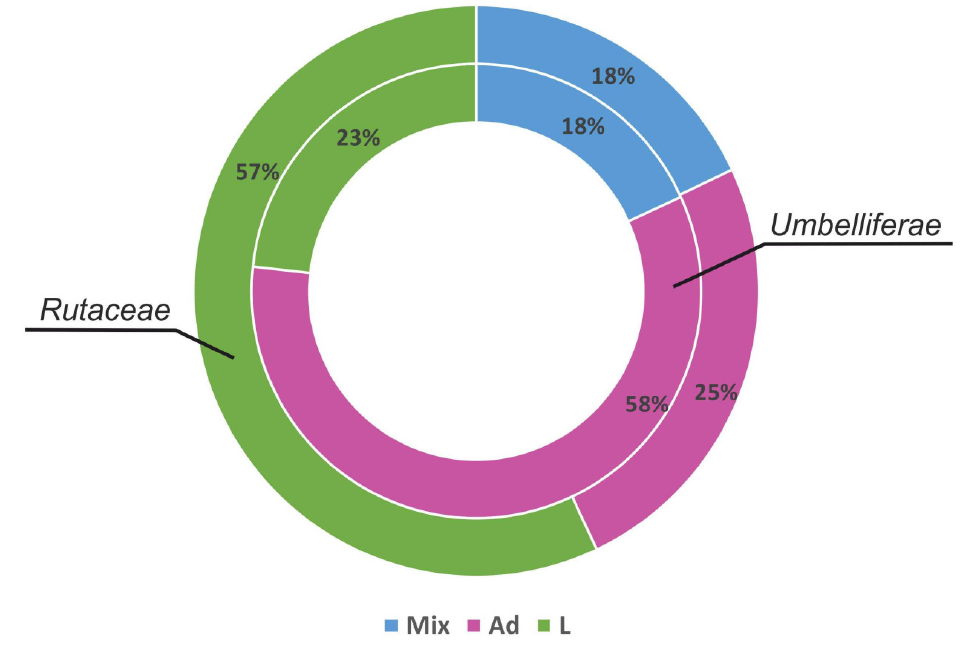
Figure 4. Distribution of linear and angular pyranocoumarins within the Umbelliferae and Rutaceae families. Mix-Ad and L pyranocoumarins; Ad-angular 7,8-pyranocoumarin; L-linear 6,7-pyranocoumarin.